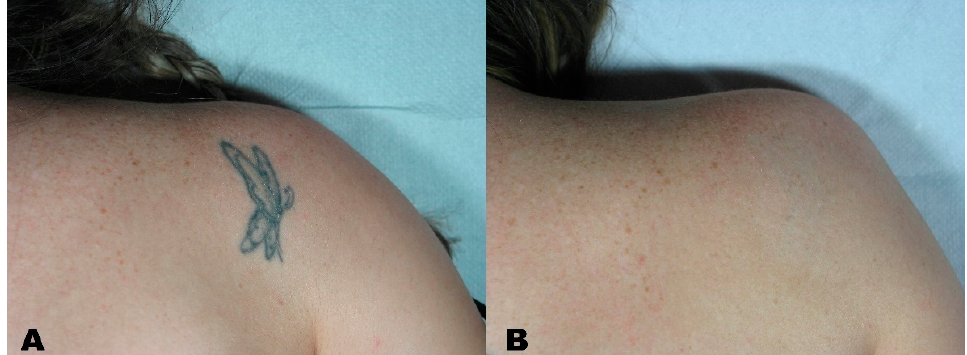
Figure 2. ( A ) Picture before starting tattoo removal treatment, and ( B ) the same region at the 6-month follow-up, after all tattoo removal sessions had been completed.